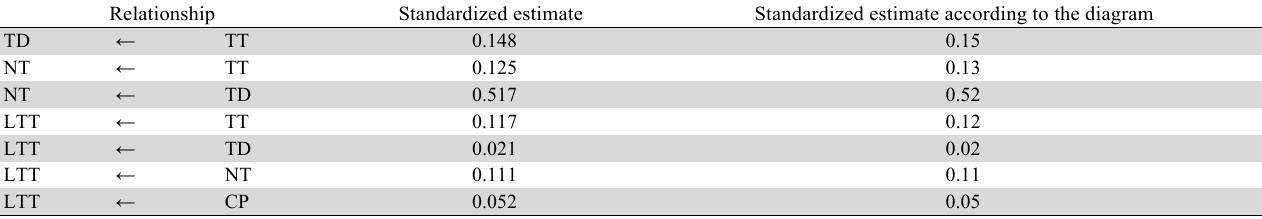
Results of the structural model analysis according to standardized coefficients